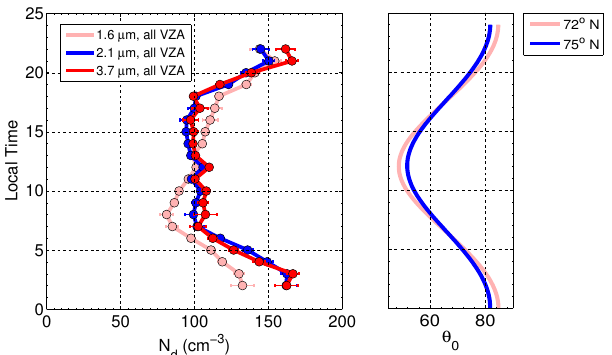
Figure 10. N d (left panel) and θ 0 (right panel) vs. local time of day. For the r e2 . 1 and r e3 . 7 based N d retrievals, the flatness of the curves for the times corresponding to lower θ 0 suggests that there is little physical diurnal cycle of N d . This suggests that the changes seen at high θ 0 are the result of retrieval artifacts and not physical effects. All VZA values are included and N d values are shown for retrievals made using r e1 . 6 , r e2 . 1 and r e3 . 7 . For the θ 0 plot, values are shown at the most southern (72 ◦ N) and northern (75 ◦ N) edges of the region. Over the period of study, time variation of θ 0 from day to day was very slight for a given local time and grid box. Table 4. Results from the example calculations of 3-D radiative ef- fects at small averaging scales, as demonstrated in Fig. 17, except that results from various other view angles (VZA) and relative az- imuth angles ( φ ) are also shown. 3-D effects at high θ 0 are assumed to cause an equal increase and decrease ( 1R ) in the reflectances of both the absorbing band ( R ab ) and the non-absorbing band ( R nab ). For this demonstration it is assumed that there are an equal